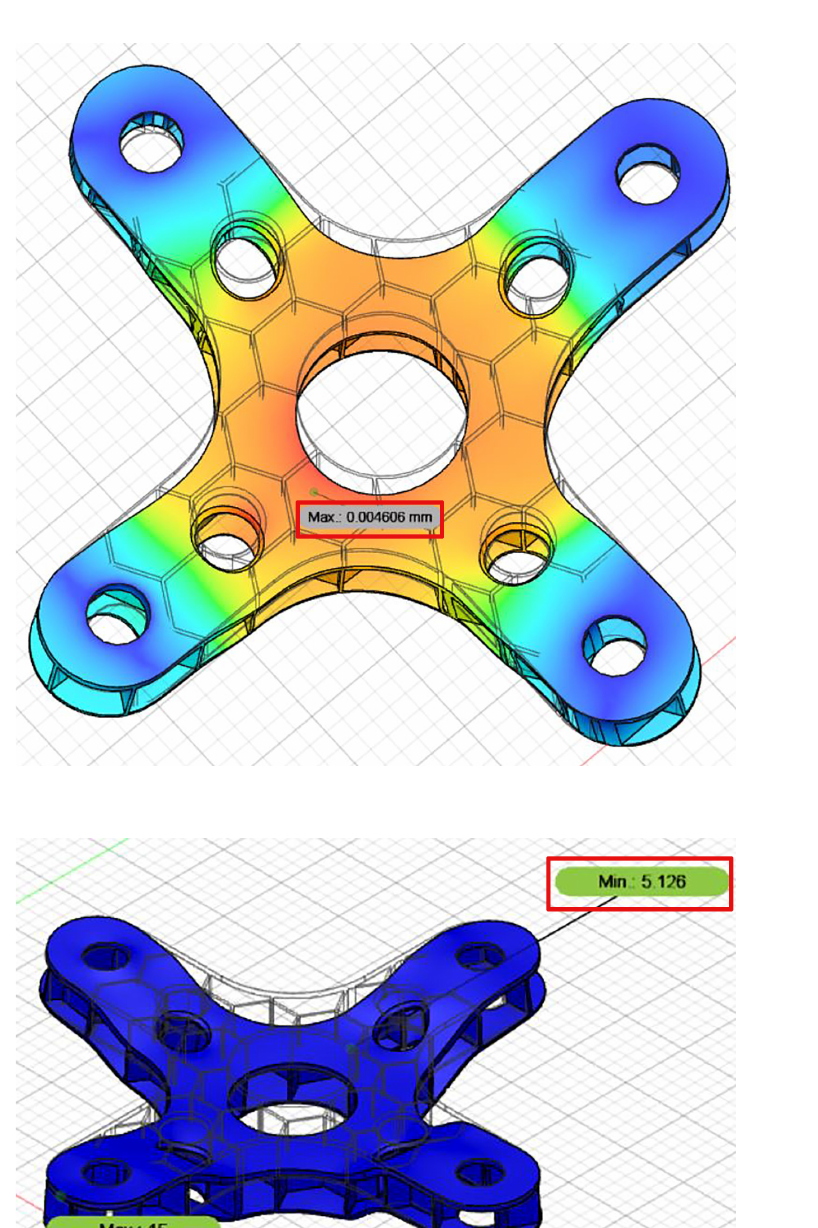
Figure 12. Static analysis of